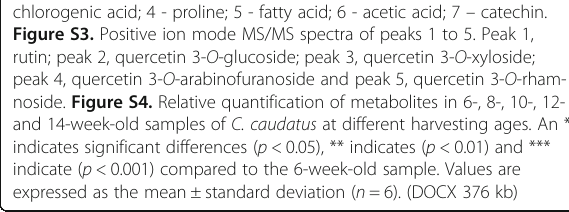
noside. Figure S4. Relative quantification of metabolites in 6-, 8-, 10-, 12- and 14-week-old samples of C. caudatus at different harvesting ages. An * indicates significant differences ( p < 0.05), ** indicates ( p < 0.01) and *** indicate ( p < 0.001) compared to the 6-week-old sample. Values are expressed as the mean± standard deviation ( n = 6). (DOCX 376